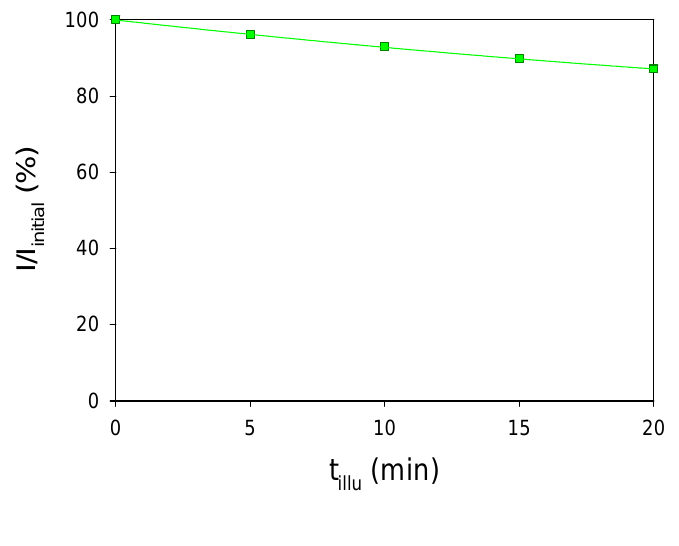
Figure 9. Photodegradation of AA-PSP in